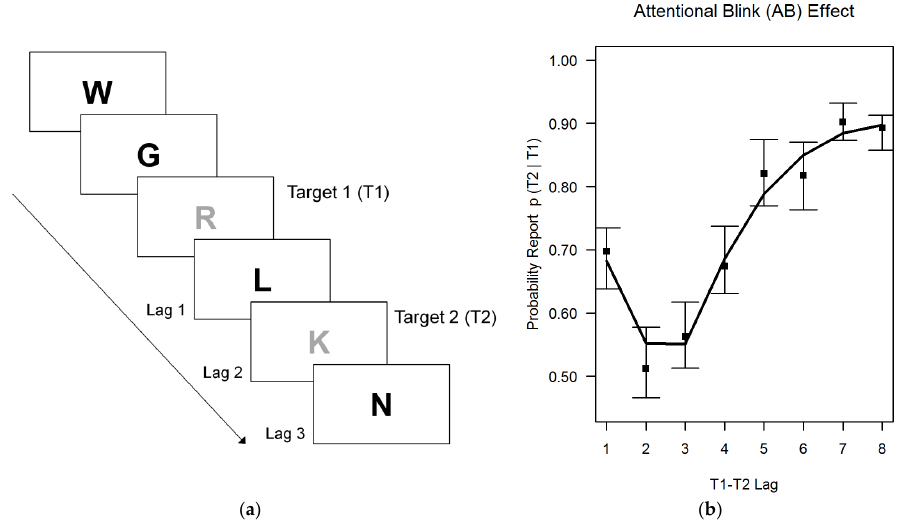
Figure 2. ( a ) Rapid Serial Visual Presentation (RSVP) Paradigm and ( b ) Attentional Blink (AB)